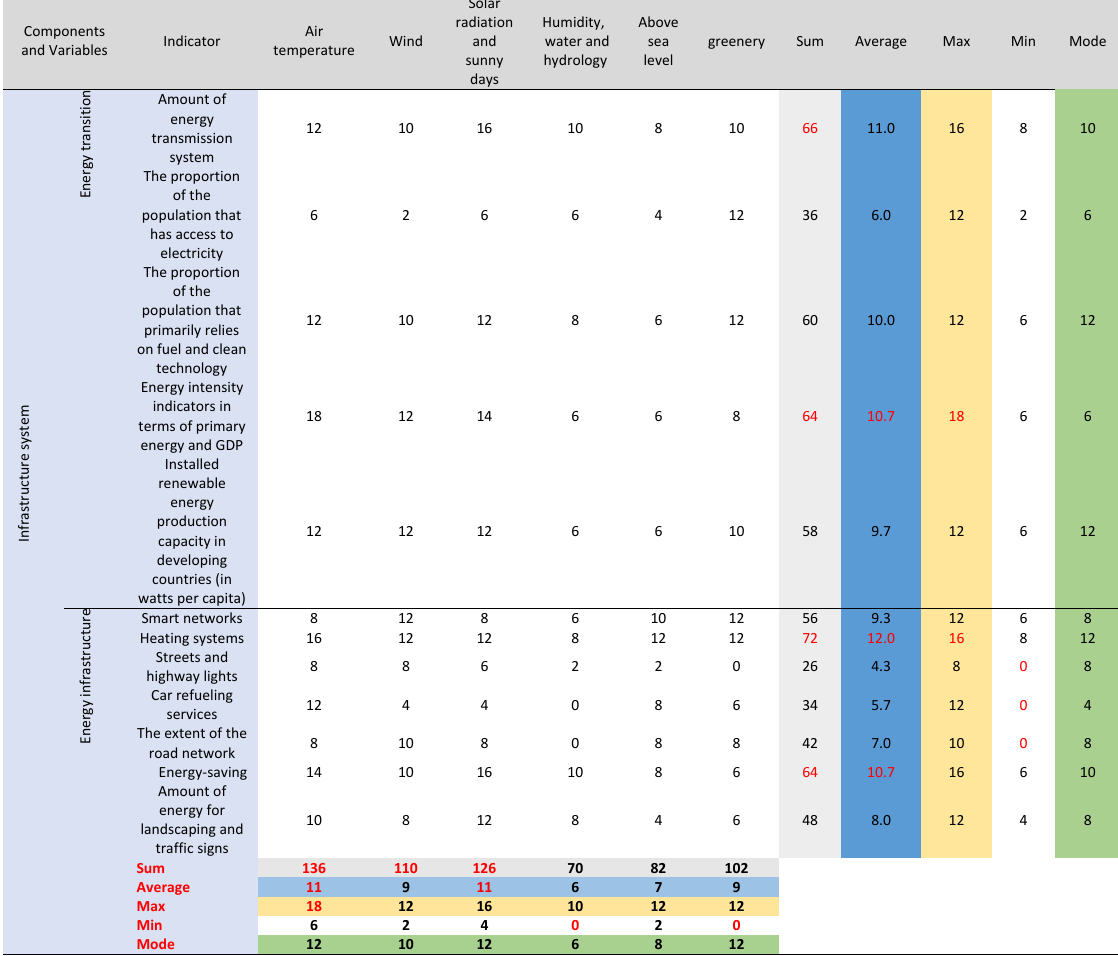
Table 6: Relation between infrastructure system and climate indicators Solar radiation Humidity, Above water and sea hydrology